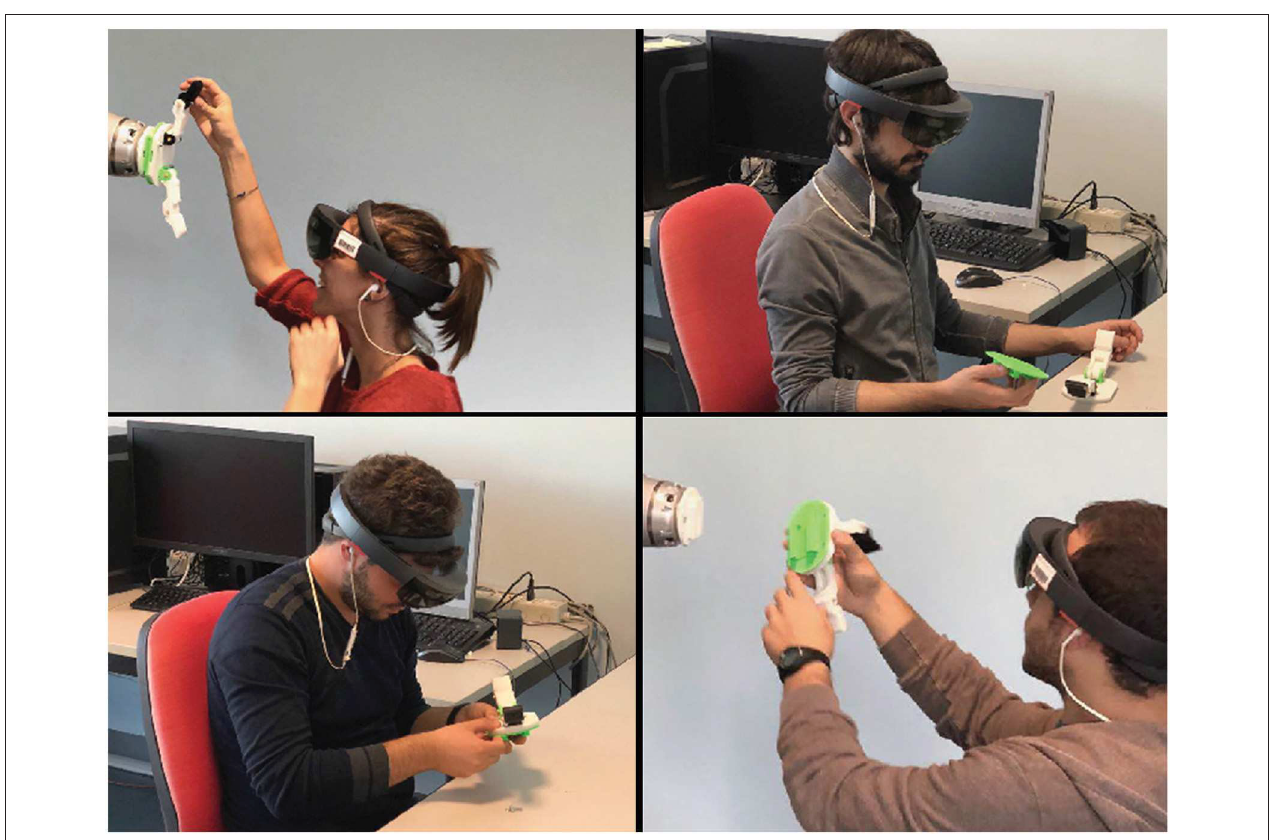
FIGURE 8 | Users evaluating the multi-users mixed reality environment.